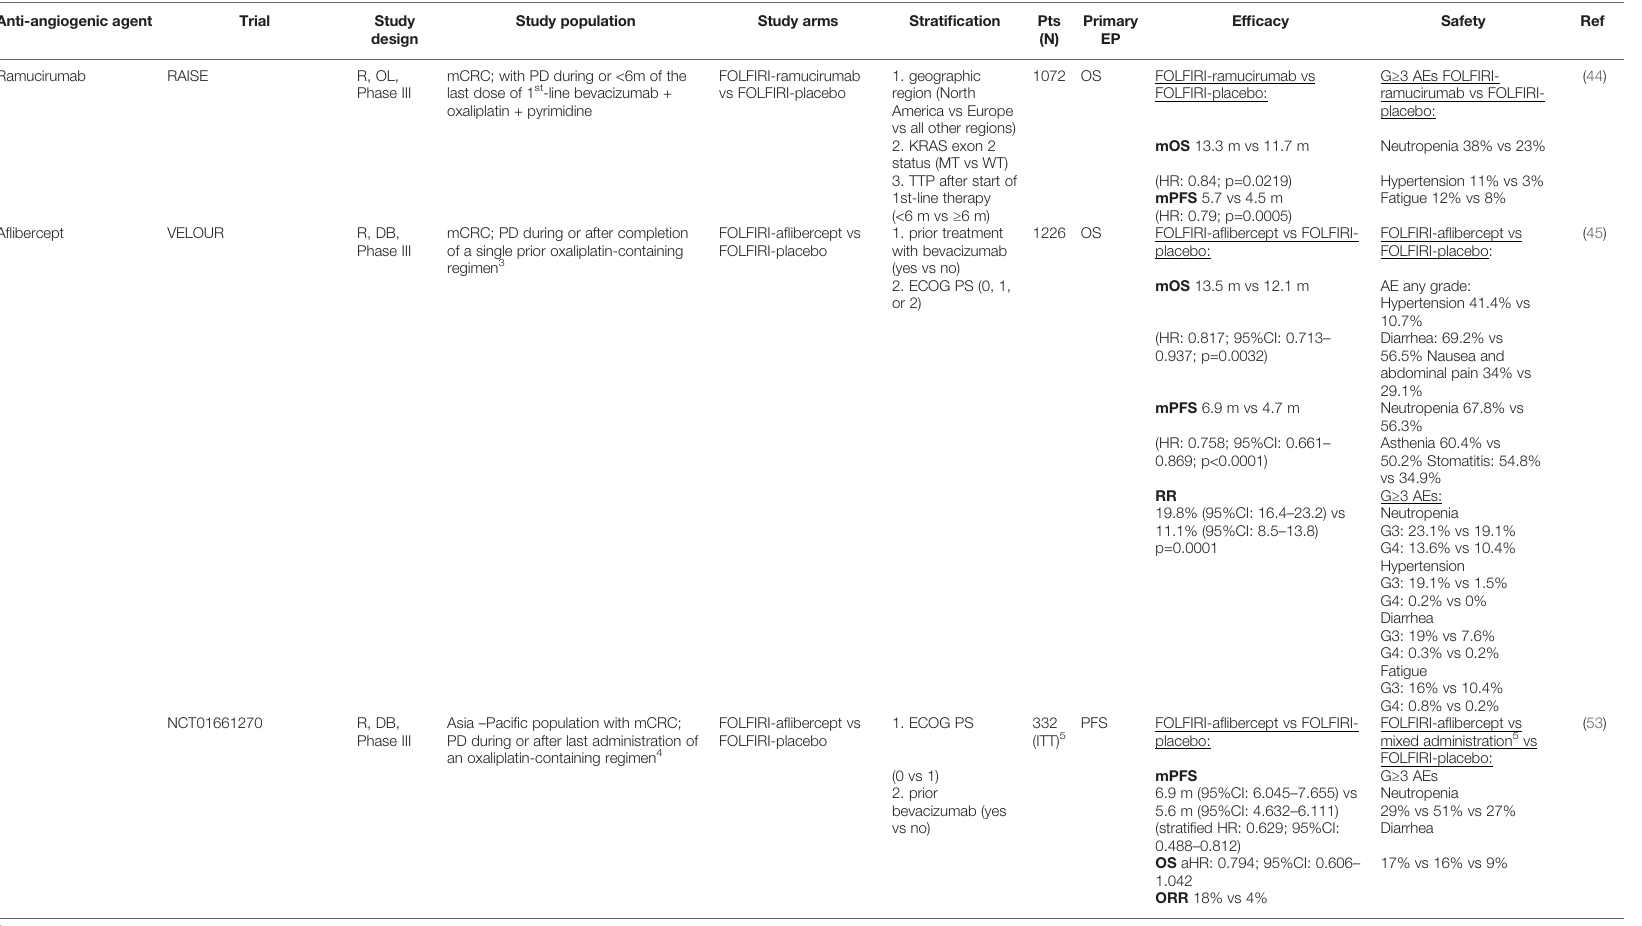
FOLFIRI-a fl ibercept vs FOLFIRI- placebo: